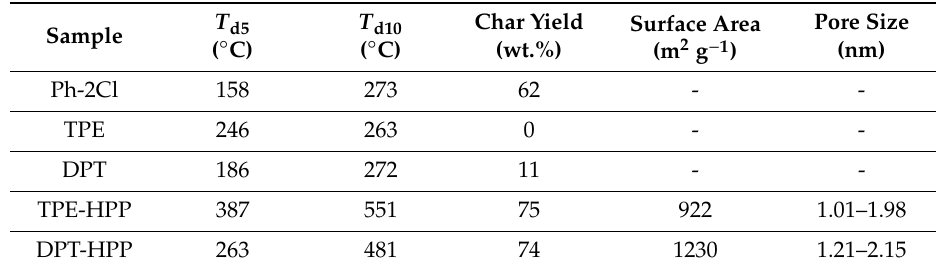
Figure 4. ( A , B ) TGA analyses of Ph-2Cl, TPE, DPT, TPE-HPP, and DPT-HPP. Table 1. Thermal stability and porosity properties of TPE-HPP and DPT-HPP, and comparison with their corresponding